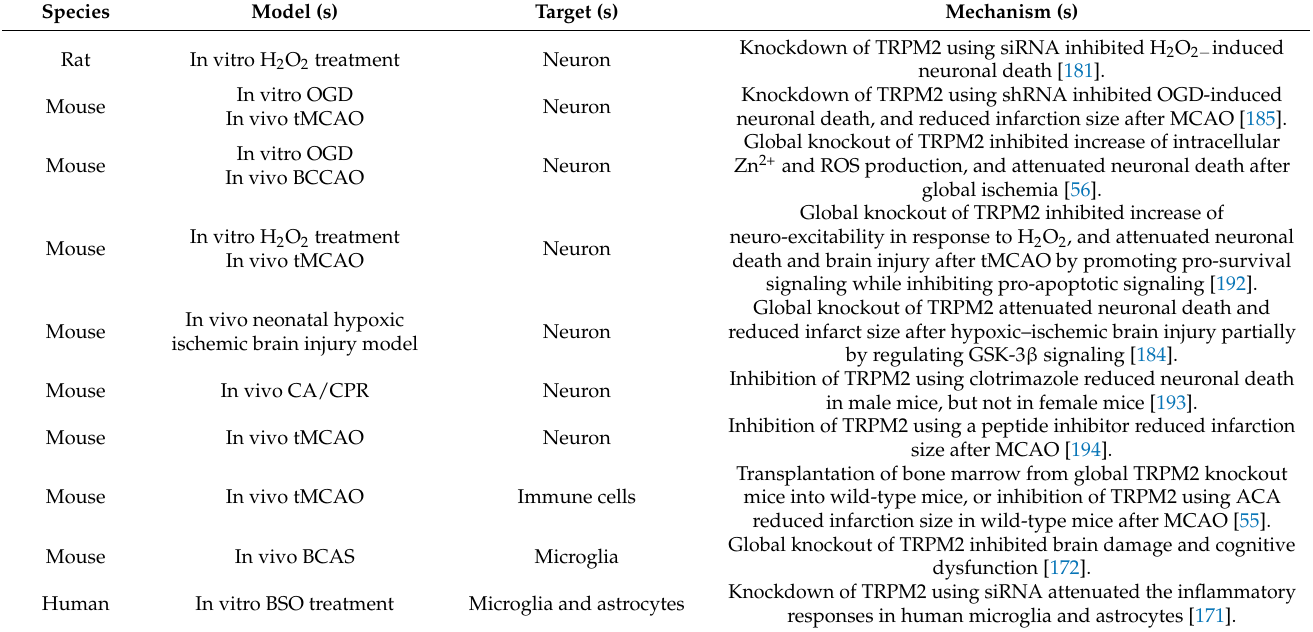
Table 1. Summary of studies on the role of TRPM2 in aggregating ischemic brain/neuron